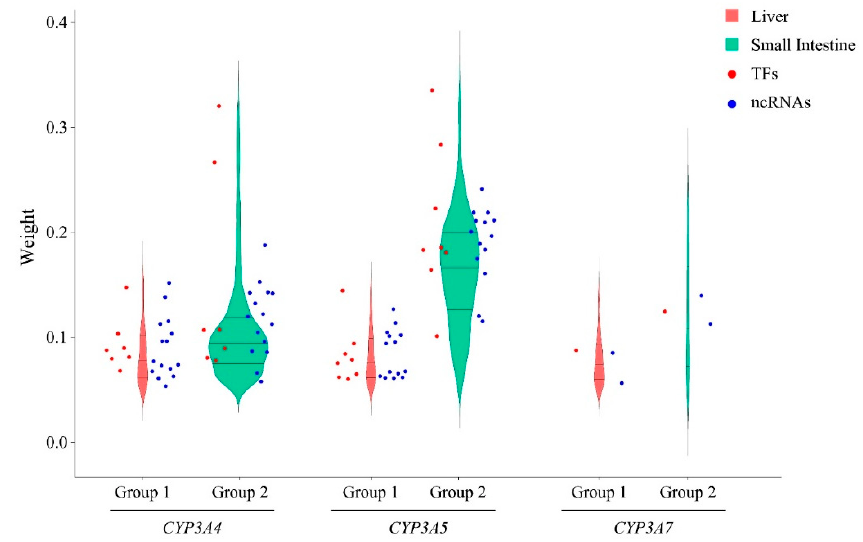
Figure 6. Comparison of CYP3A expression regulatory networks between liver and small intestine. The y-axis displays the weight values calculated by WGCNA. Red and blue dots represent the overlapping TFs and ncRNAs associated with each CYP3A in the liver and small intestine, respectively. The red and green violin plots represent all TFs and ncRNAs associated with each CYP3A in the liver and small intestine, respectively.